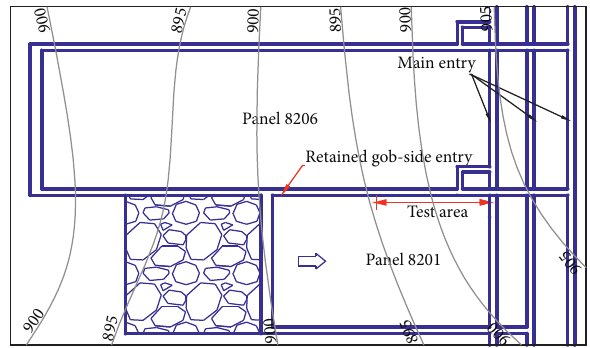
Figure 2: Location of 5201 retained gob-side entry.